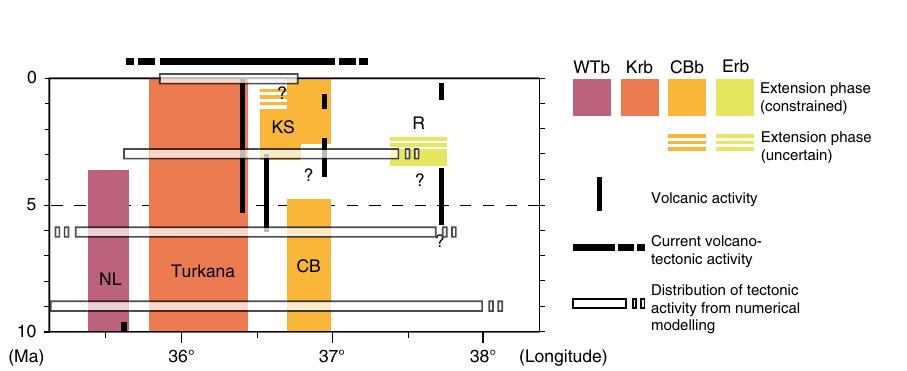
Fig. 6 Numerical modelling of rift interaction in the Turkana depression. a Initial depth distribution of the 1300 °C isotherm and the Moho. Three distinct model domains are labelled as follows: P: Plateaus; R: Ethiopian and Kenyan rifts; T: Turkana depression. b Geotherms (top axis, red lines) and yield strength pro fi les (bottom axis, black lines) in the different model domains. Yield strengths have been computed for the initial bulk extension rate of the models, i.e. 2.7×10 − 16 1/s, in the different domains. c Evolution of the deformation pattern illustrated as second invariant of strain rate at different amounts of bulk extension. Note the progressive narrowing of deformation in the Turkana depression for increasing extension; in the latest stages of rifting, extension is strongly localised within a continuous narrow region of strain connecting the offset major rift segments. d Evolution of model surface topography; white bars show the direction of the minimum horizontal stress (local direction of extension). Semi-transparent strain rate fi eld is shown for reference. Note the dominant WNW-ESE orientation of the minimum horizontal stress in the oblique (roughly NE-SW trending) transfer zone, which deviates from the imposed roughly E-W plate motion. ER: Ethiopian rift; KR: Kenyan rift; T E and T K indicate the overlapping tips of the Ethiopian and Kenyan rift valleys, respectively; also shown are the regions approximately corresponding to the Gofa Province, Lake Turkana basin and Ririba rift